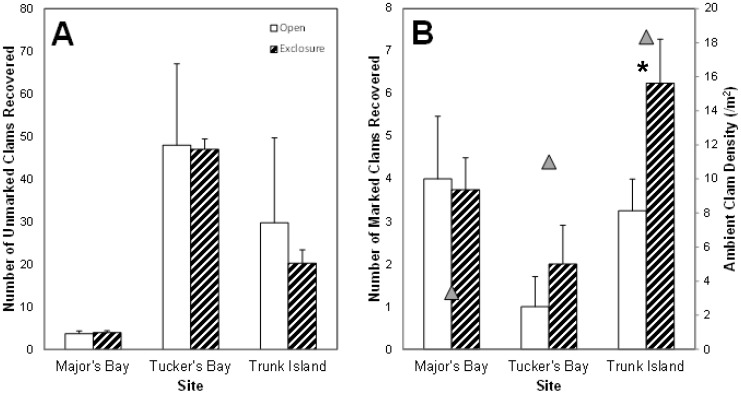
Vertical bar charts of calico clam recovery from field manipulation experiments.Unmarked (A) and marked (B) calico clam recovery comparisons between open (white) and exclosure (black and white diagonal strips) patches at three sites within Harrington Sound. In B, Ambient calico clam density is plotted for each site (gray triangles) along the secondary y-axis. * - denotes clam recovery was significantly different between patches at p<0.05 from t-test.